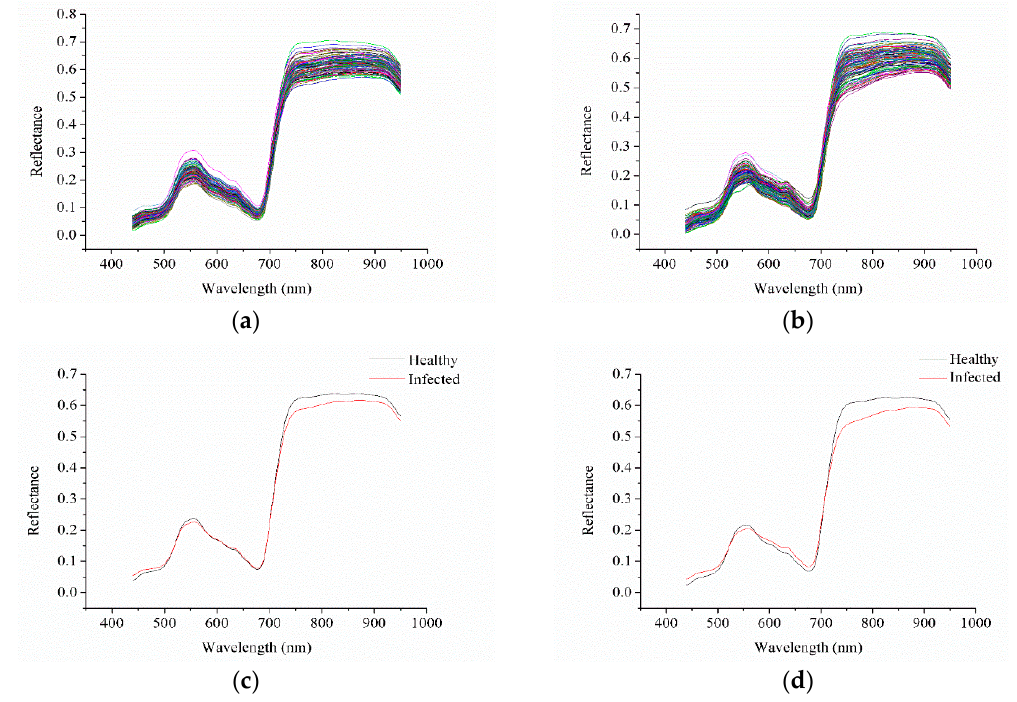
Figure1. Spectra of sample set 1 and 2 ( a , b ) and corresponding average spectra of healthy and infected stems of sample set 1 and 2 ( c , d ).